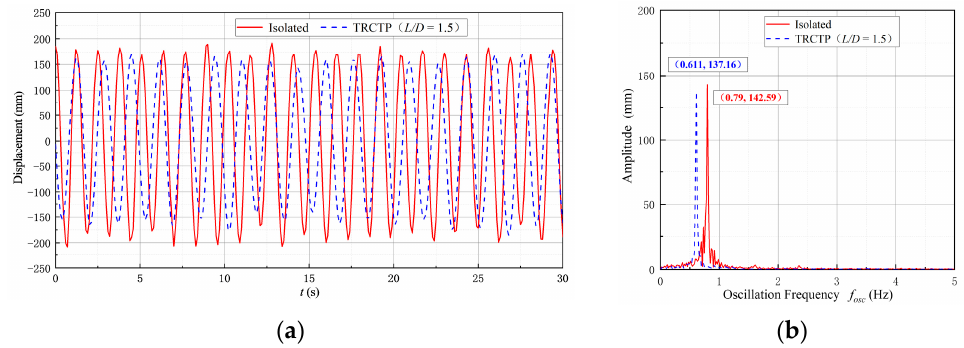
Figure 11. Typical displacement and spectra comparison at U r = 11 ( L / D = 1.5). ( a ) Comparison of displacement time history; ( b ) Comparison of spectra.